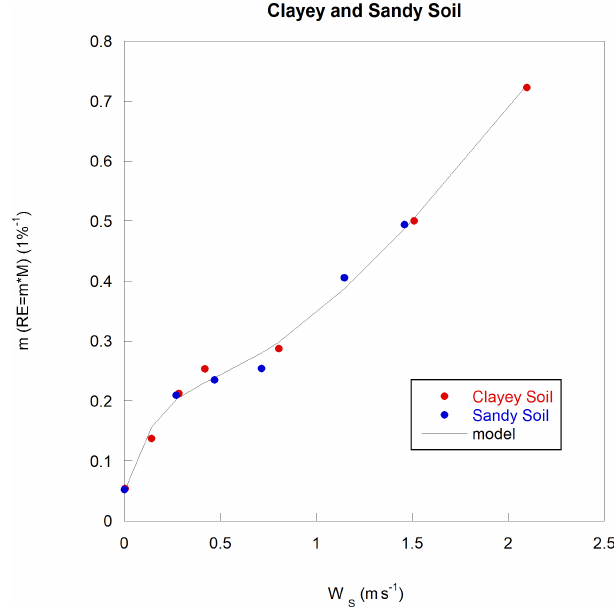
Figure 6. Z total and Z 10 − 30 versus time for sandy soil at a relatively strong wind of 1.15ms − 1 . Insert, the same values of Z total versus Z 10 − 30 .